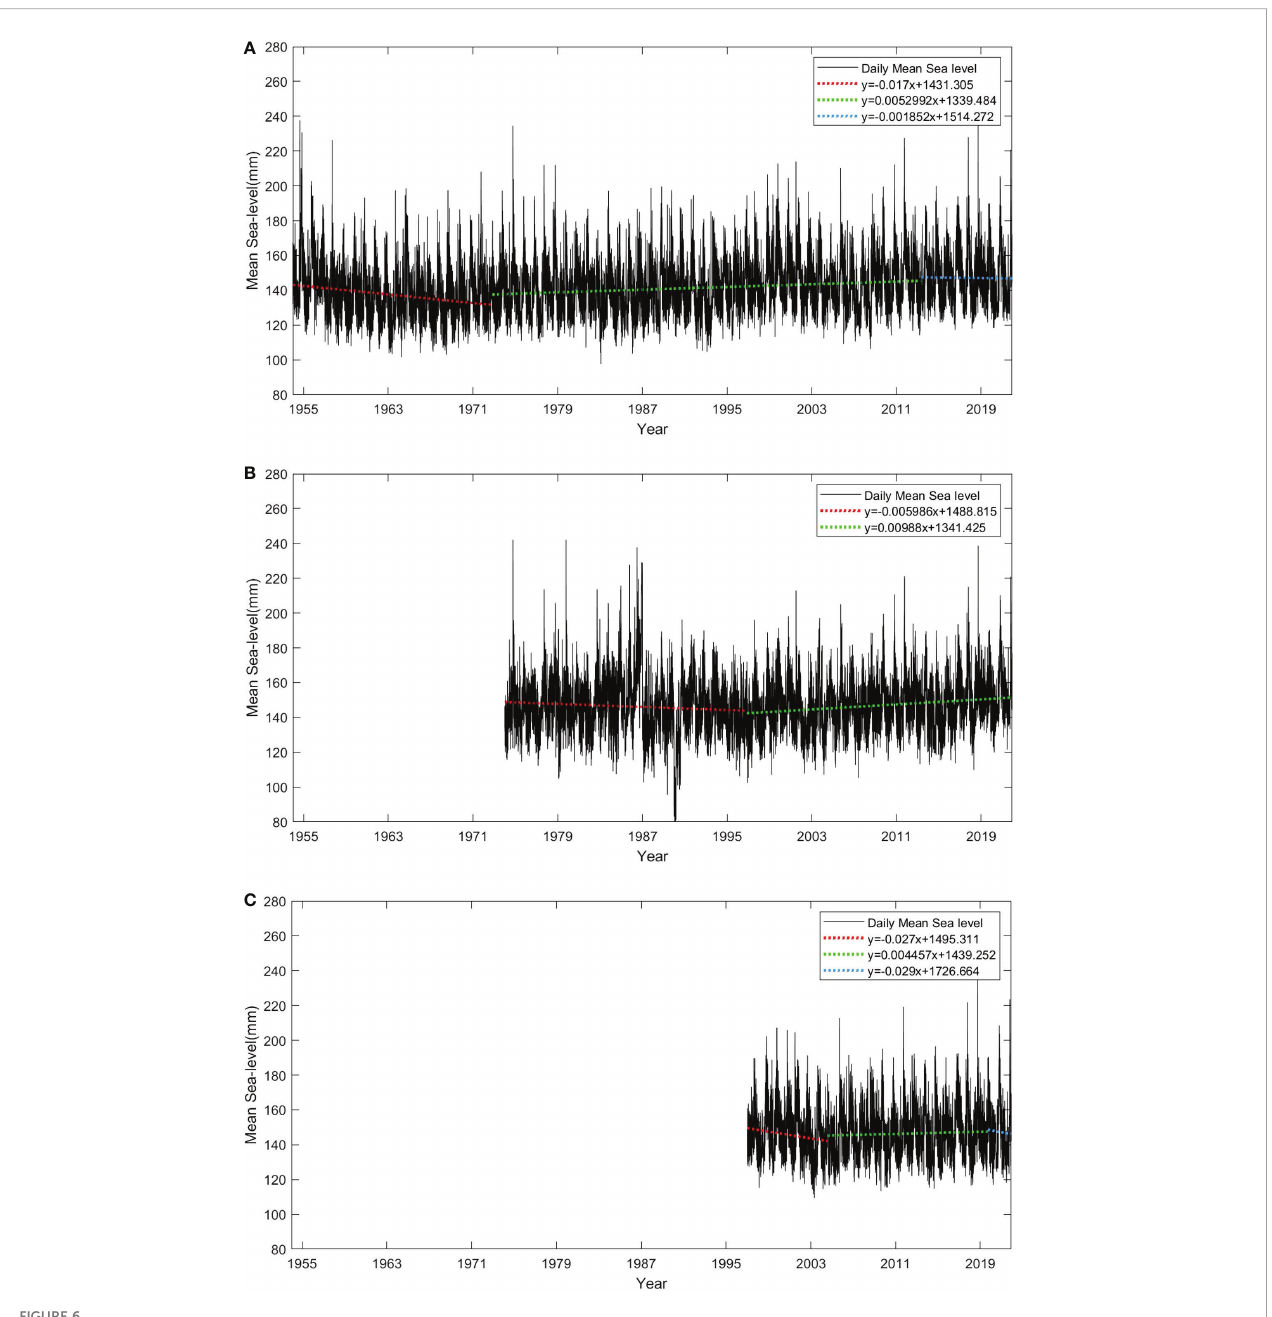
FIGURE 6 Daily tide gauge data. Linear regression of daily mean RSL based on the last IMF component of EMD results. (A – C) are the QUB, TBT, and SPW,